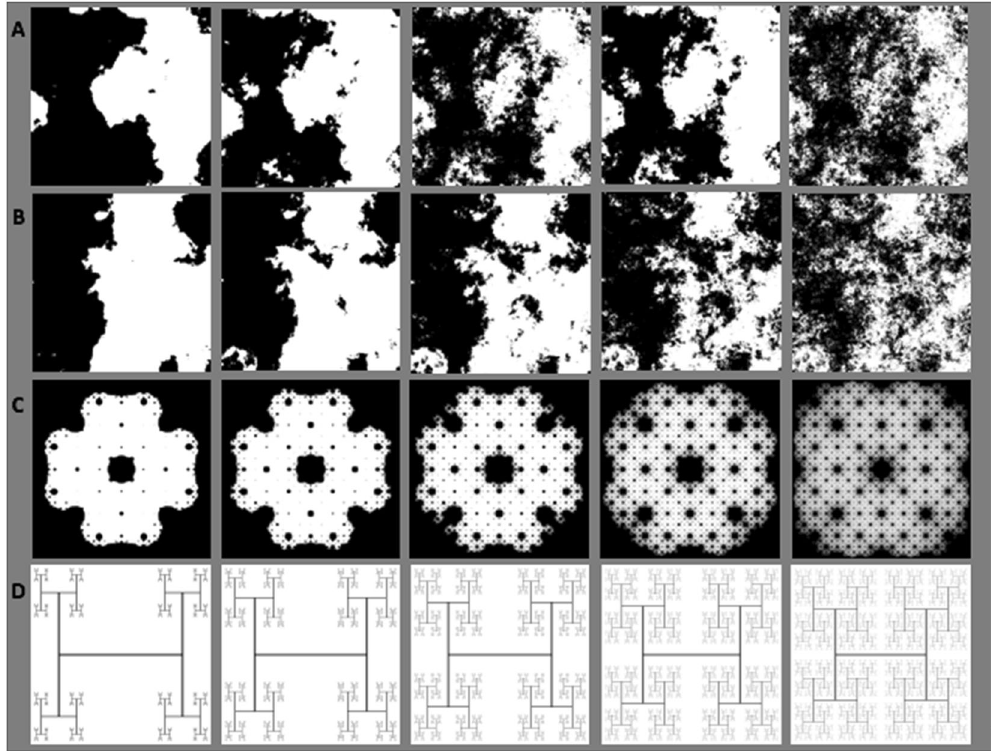
Fig. 1 Fractal stimuli. A – D Examples of the two statistical A and B and two exacts C and D fractal seeds used in the experiment. The sequence of images depicts the progression from low ( D = 1.1 on the far left) to high ( D = 1.9 on the far right)